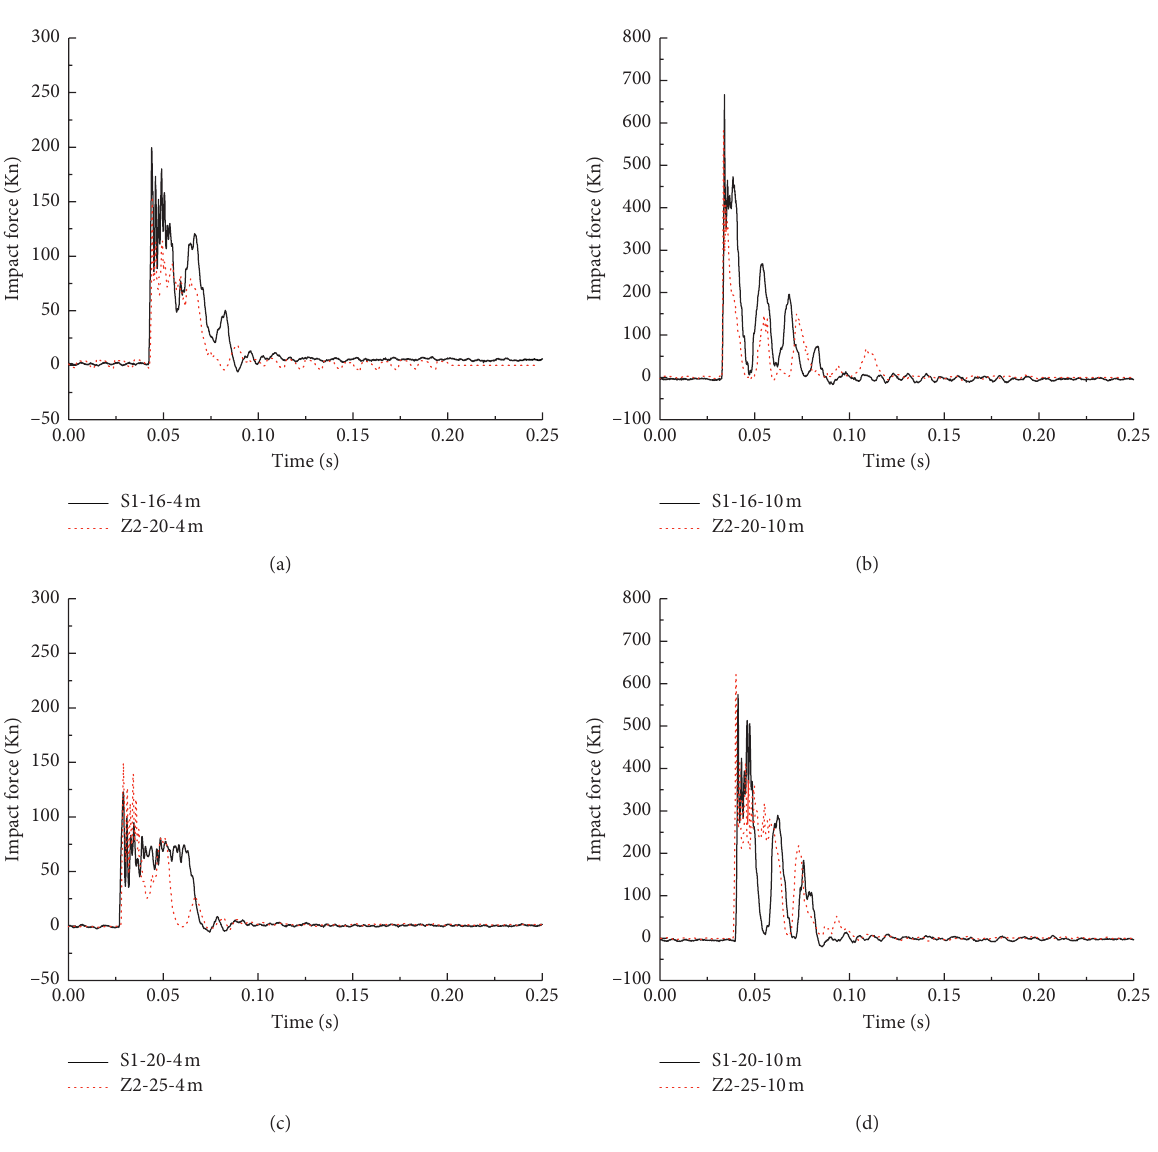
Figure 10: Time history curve of the impact force when the drop hammer is lifted to 4m and 10m, respectively. Table 7: Impact test results and